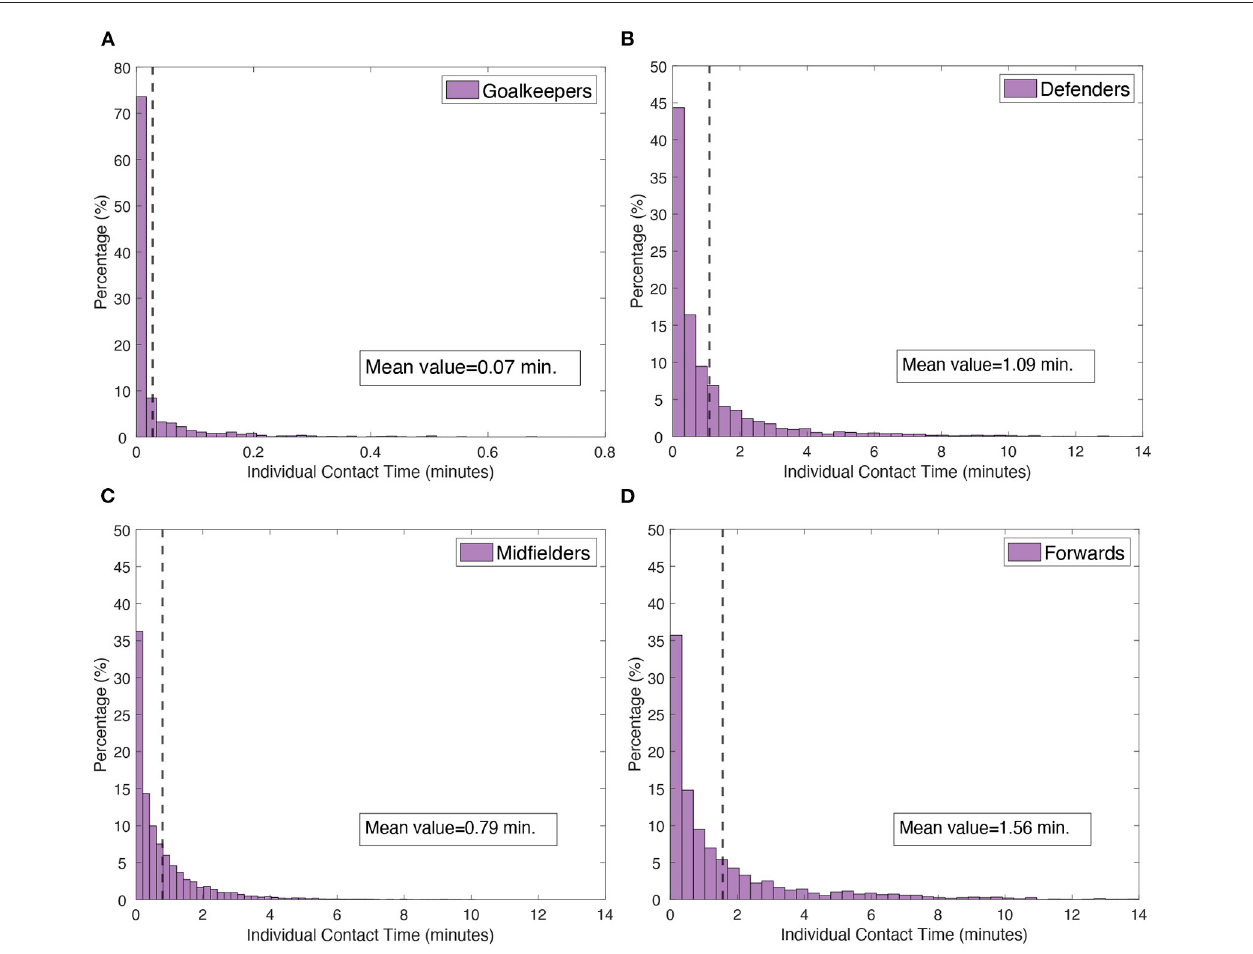
FIGURE 5 | Individual contacts by player’s position. Probability distribution functions (PDFs) of the accumulated time t accum between pairs of players (player-player interaction), according to the position of each player: (A) goalkeepers, (B) defenders, (C) midfielders and (D) forwards. Note the difference in scale of the plot (A) . Contact time refers only to opponents. Dashed lines indicate the average value of the contact time of a player with an opponent, whose precise value is given in the box. The probability distribution functions show how heterogeneous the contacts are and, at the same time, how the peaks of all distributions are close to